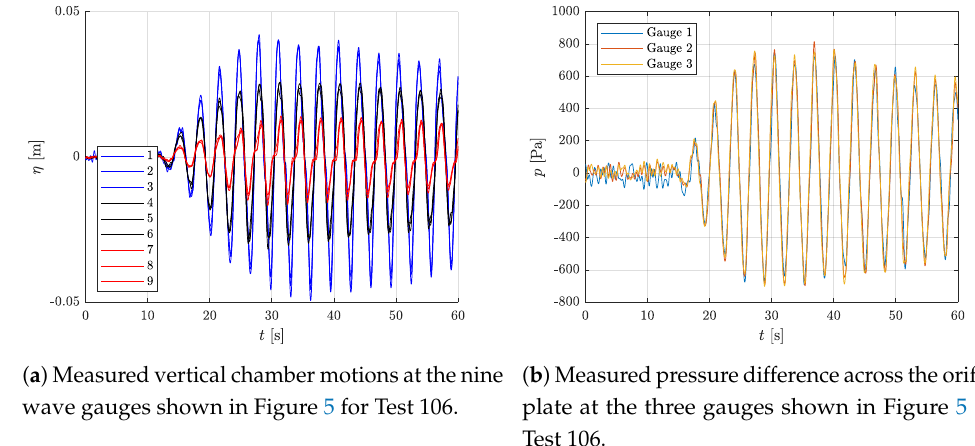
Figure 7. Measured chamber motions and pressure difference across the orifice plate for Test